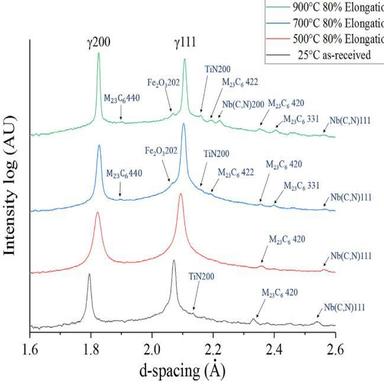
XRD characterization on precipitate evolution in Alloy 709 at high temperatures with scattering vector parallel to axial direction. The XRD profiles are plotted in logarithm intensity scale.